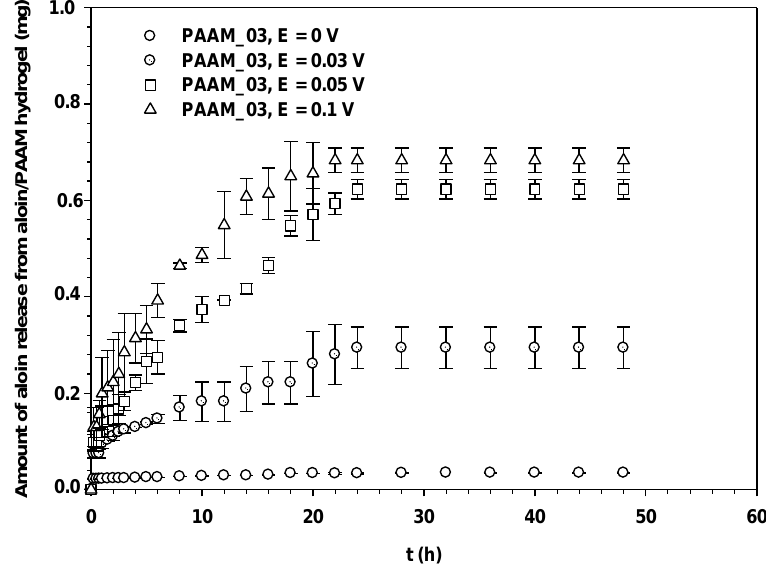
Figure 6. Amounts of aloin released from aloin/PAAM hydrogel (PAAM_03) at time t vs. t (h) at various electric field strengths, pH = 5.5, and at 37